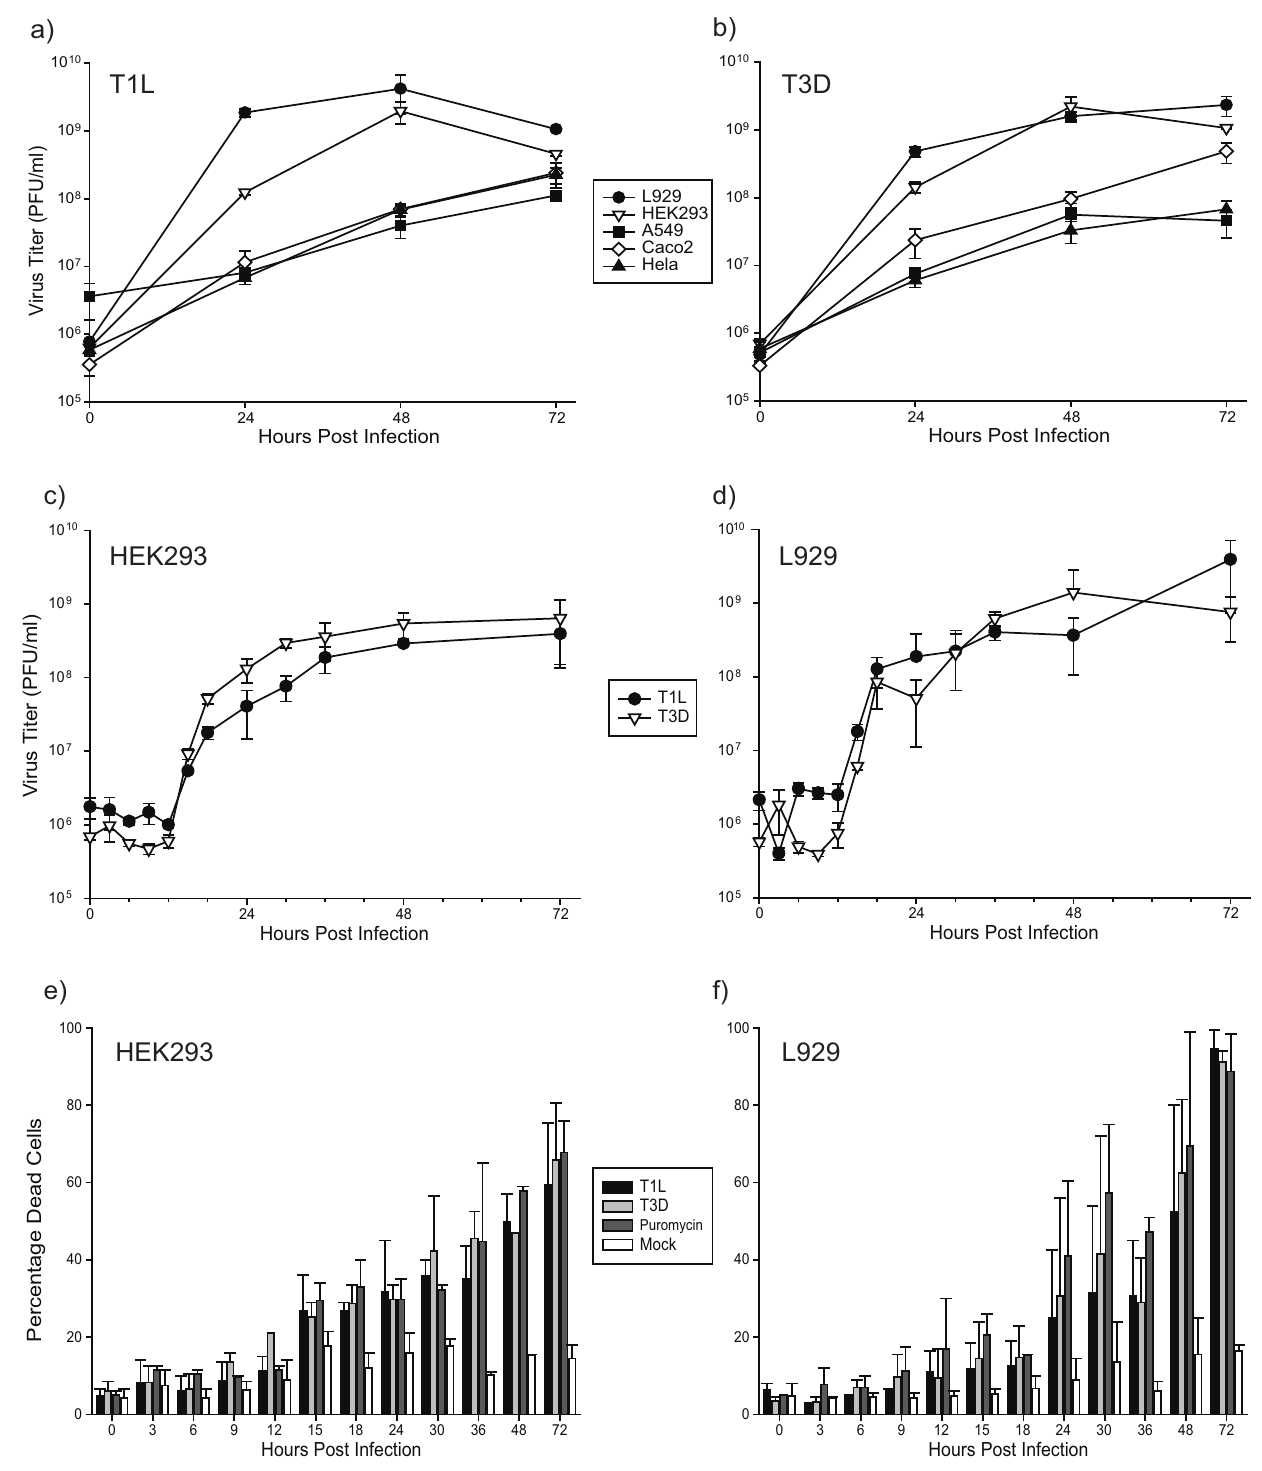
Figure 1. Kinetics of reovirus growth and viral-induced cytopathology. Each of five different cell lines (L929, A549, HEK293, CaCo 2 and Hela) were infected at MOI =1 PFU/cell with T1L (a) or T3D (b). Cell lysates were harvested at 0, 24, 48 and 72hpi and titrated. Experiments were performed in triplicate; error bars represent standard error. Virus titers were greatest in the L929 and HEK293 cells for both virus strains. HEK293 (c) and L929 (d) cells were then re-analyzed as in (a) and (b) after infection at MOI =5 and at additional time points. Aliquots of the infections in (c) and (d) were also assessed for cell viability by trypan blue exclusion (e and f, respectively), with 100 m g/ml puromycin used as a positive cell killing control. Experiments were performed in duplicate; error bars represent standard